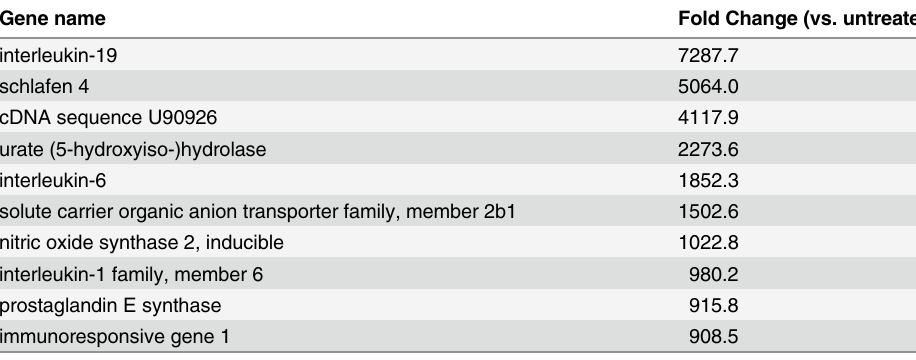
Table 1. Upregulated genes in activated microglia (Top